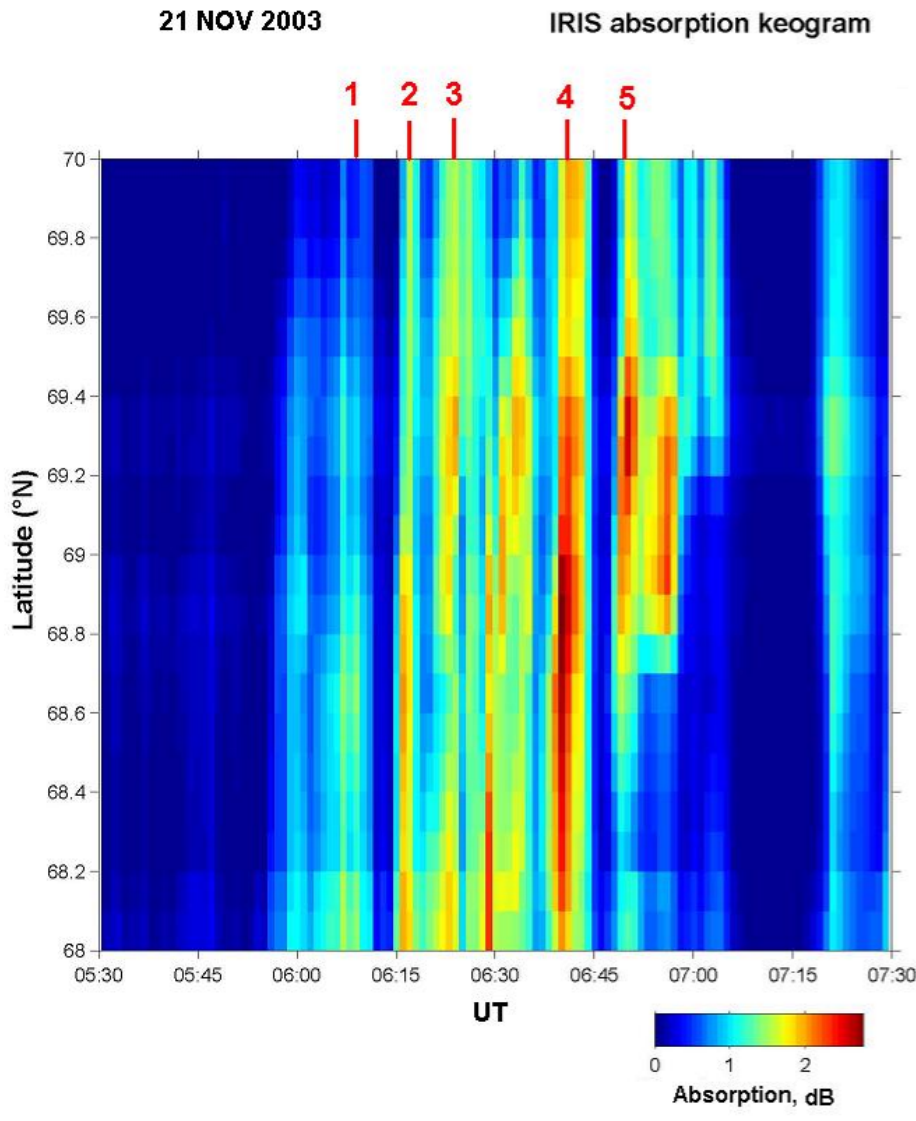
Fig. 7. IRIS absorption keogram (05:30–07:30 UT) in geographic coordinates; the red numbers show the strong electron precipitation